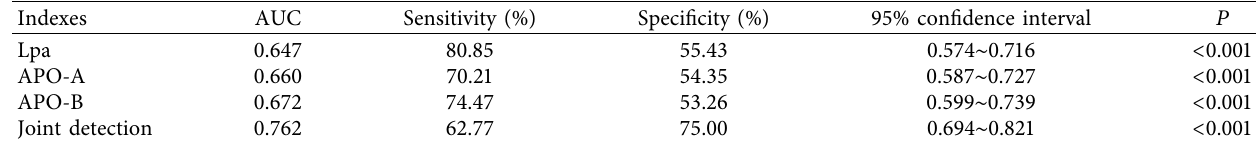
Figure 1: Te ROC curve of Lpa, APO-A, and APO-B in the diagnosis of MCA stenosis in CIS patients. Table 4: Te diagnostic value of Lpa, APO-A, and APO-B for MCA stenosis in CIS patients.